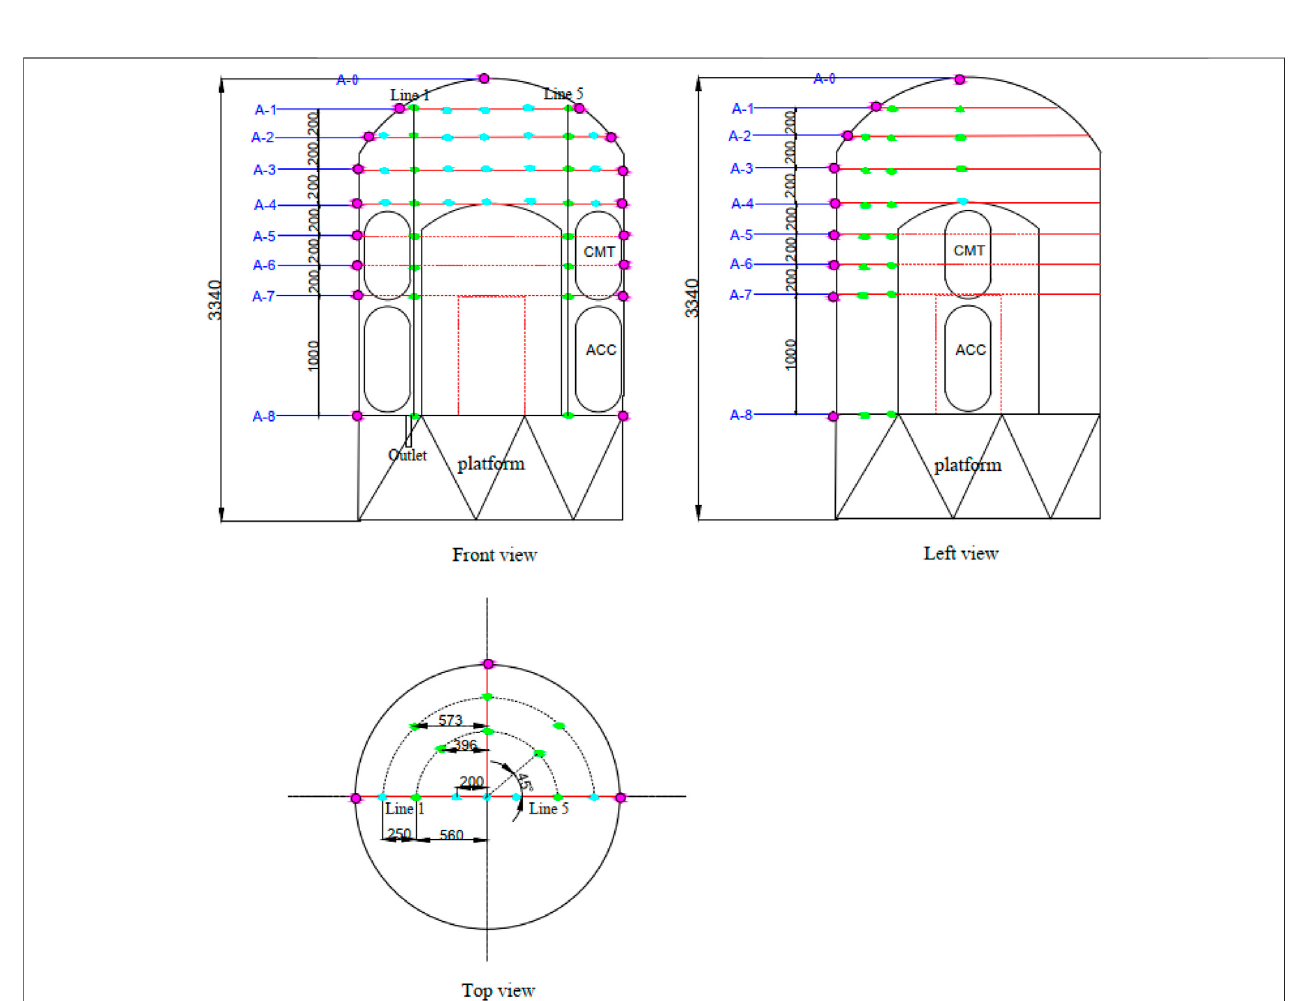
FIGURE 2 | Distribution of thermocouples.